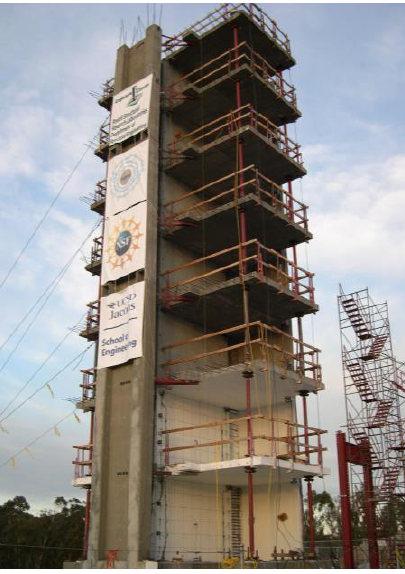
Figure 1. Test structure [24].